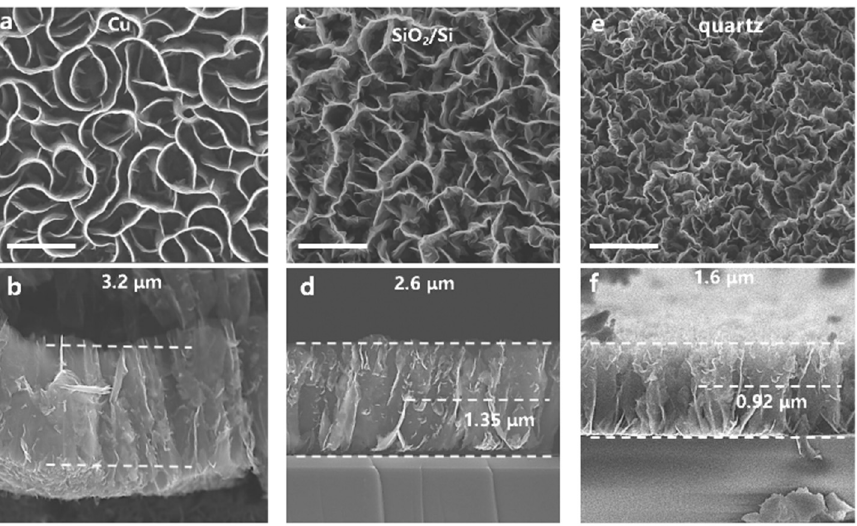
Figure 1. SEM images of morphology of vertical graphene (VG) on substrates with different conduc- tive types. Top-view ( a ) and cross-sectional ( b ) images of VG on Cu; top-view ( c ) and cross-sectional ( d ) images of VG on SiO 2 /Si; and top-view ( e ) and cross-sectional ( f ) images of VG on quartz. The scale bars are 1 µ